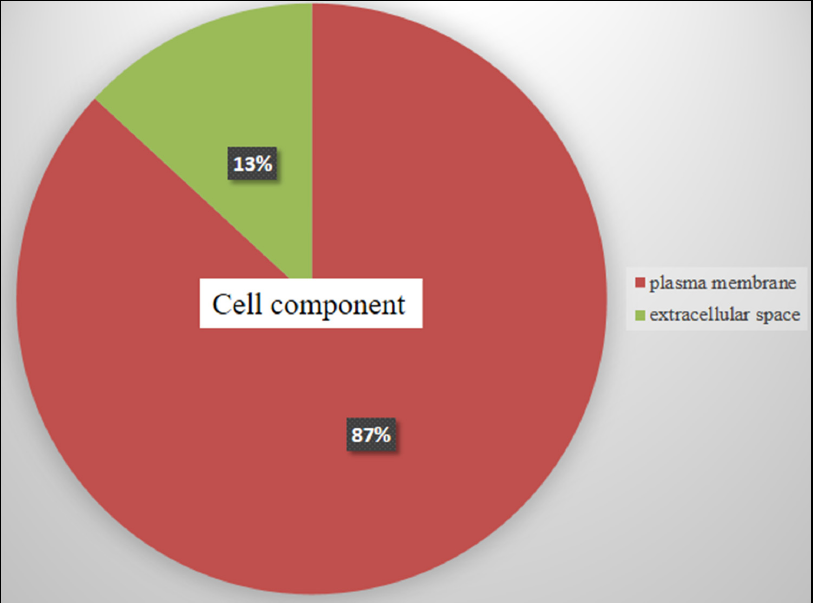
Figure 4. DAVID software analyzed the possible active locations of the significantly affected genes in the cellular components of TQ-treated HL60 cells. The majority of genes were activated in the plasma membrane, which suggests that TQ affects signaling activation in the plasma membrane. The area of each category represents the percentages of involved genes to each other ( p < 0.05). Analyzing up- and downregulated genes separately showed their critical roles in specific biological processes (Tables 2 and 3).